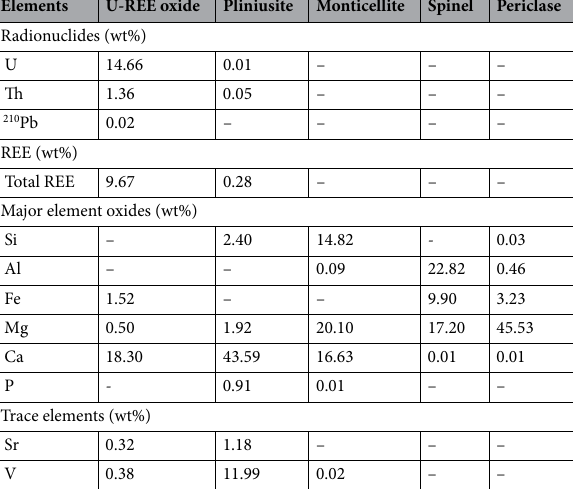
Table 1. Radionuclide, major and trace element partitioning between U-REE oxide, pliniusite, monticellite, spinel and periclase (expressed in at.%) determined by Atom Probe